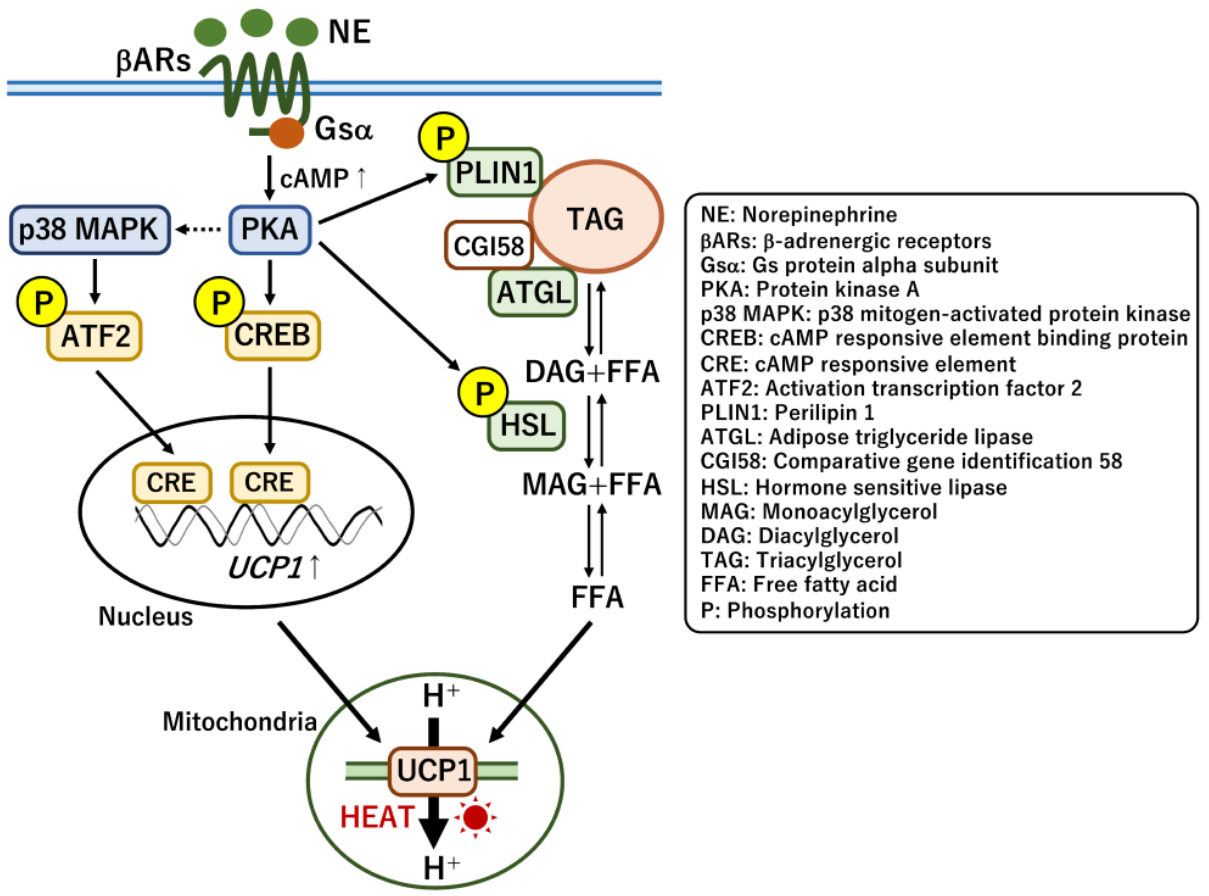
Figure 3. Regulatory mechanisms underlying UCP1-dependent thermogenesis in response to cold exposure. Upon cold exposure, norepinephrine (NE) is secreted from sympathetic nerve terminals. The activation of β-adrenergic receptors by NE increases the cellular levels of cAMP. The cAMP- dependent activation of protein kinase A (PKA) phosphorylates transcriptional factors, such as cAMP response element binding protein (CREB) and activating transcription factor 2 (ATF2), for the rapid activation of UCP1 expression. PKA also phosphorylates hormone-sensitive lipase (HSL) and perilipin 1 (PLIN1) proteins for rapid lipolysis to supply mitochondria with free fatty acids (FFAs). The simultaneous induction of UCP1 expression and FFA supply enables acute heat production upon cold exposure.